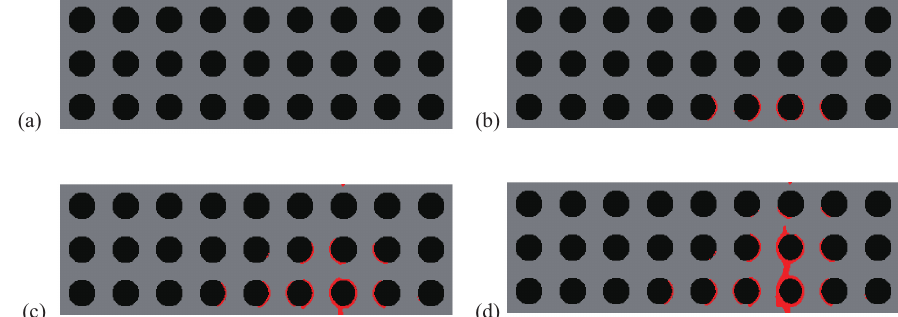
Figure 11. Crack propagation in the initial periodic composite subjected to non-symmetric three-point bending: ( a ) ¯ U = 0 mm; ( b ) ¯ U = 0.17 mm; ( c ) ¯ U = 0.24 mm; ( d ) ¯ U = 0.30 mm.